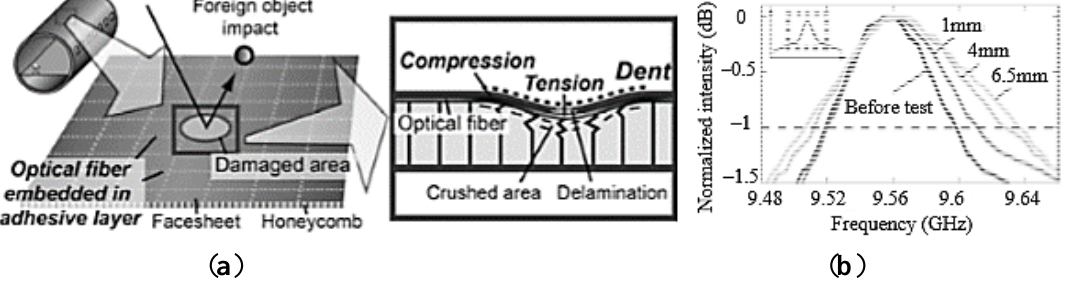
Figure 26. Impact test layout ( a ); BGS measured in the point closest to the impact location ( b )